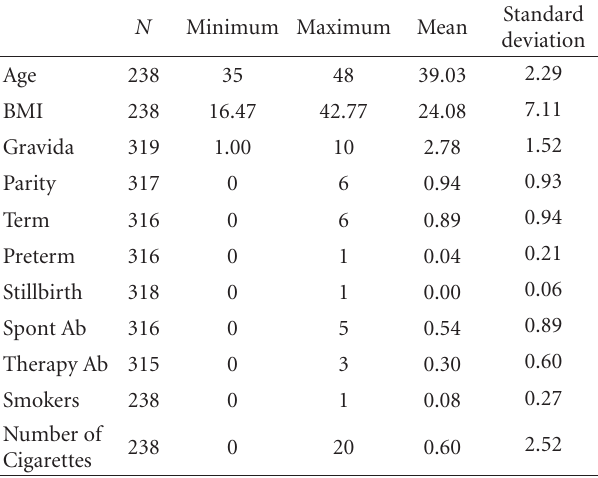
Table 1: Clinical variables. Table 2: Phytoestrogen concentration over the course of